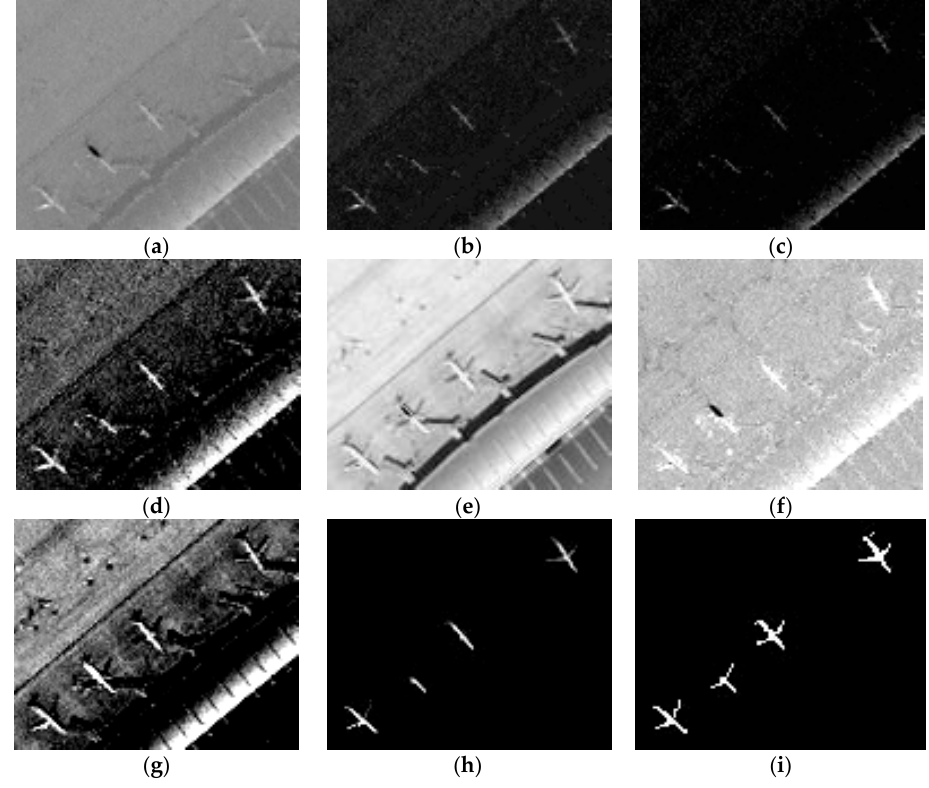
Figure 5. Detection results of the second scene of Xianyang Airport: ( a – c ) results of the hCEM algorithm for the first to third layers; ( d ) results of CEM algorithm; ( e ) results of SAM algorithm; ( f ) results of CE algorithm; ( g ) results of MPCEM algorithm; ( h ) results of SWCEM algorithm; and ( i ) reference data.